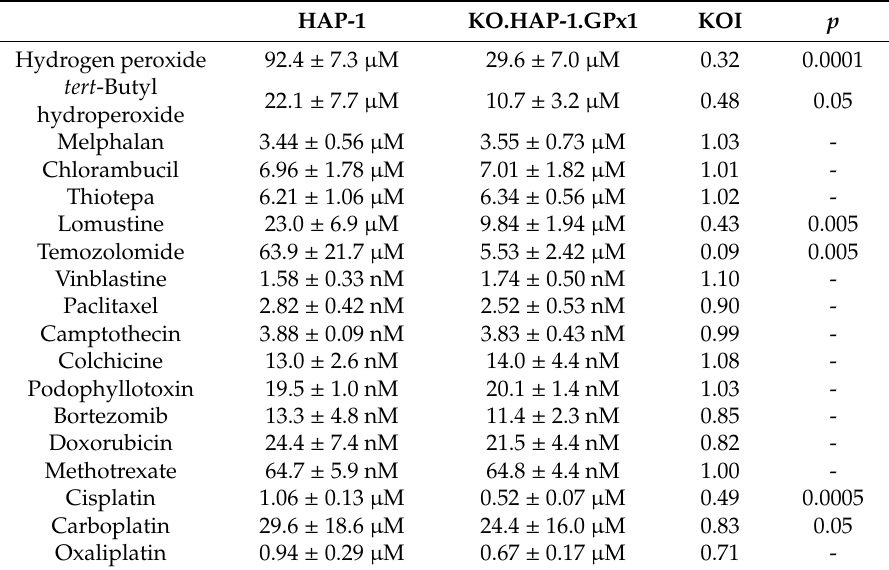
Table 1. IC 50 values for inhibition of cell viability by anticancer drugs and peroxides in HAP-1 and KO.HAP-1.GPx1 cell line and corresponding KOI values [mean ± SD; n ≥ 3]. p -Values are the levels of significance between the IC 50 values for the two cell lines as tested with a two-sided, paired t -test; only significant p -values are